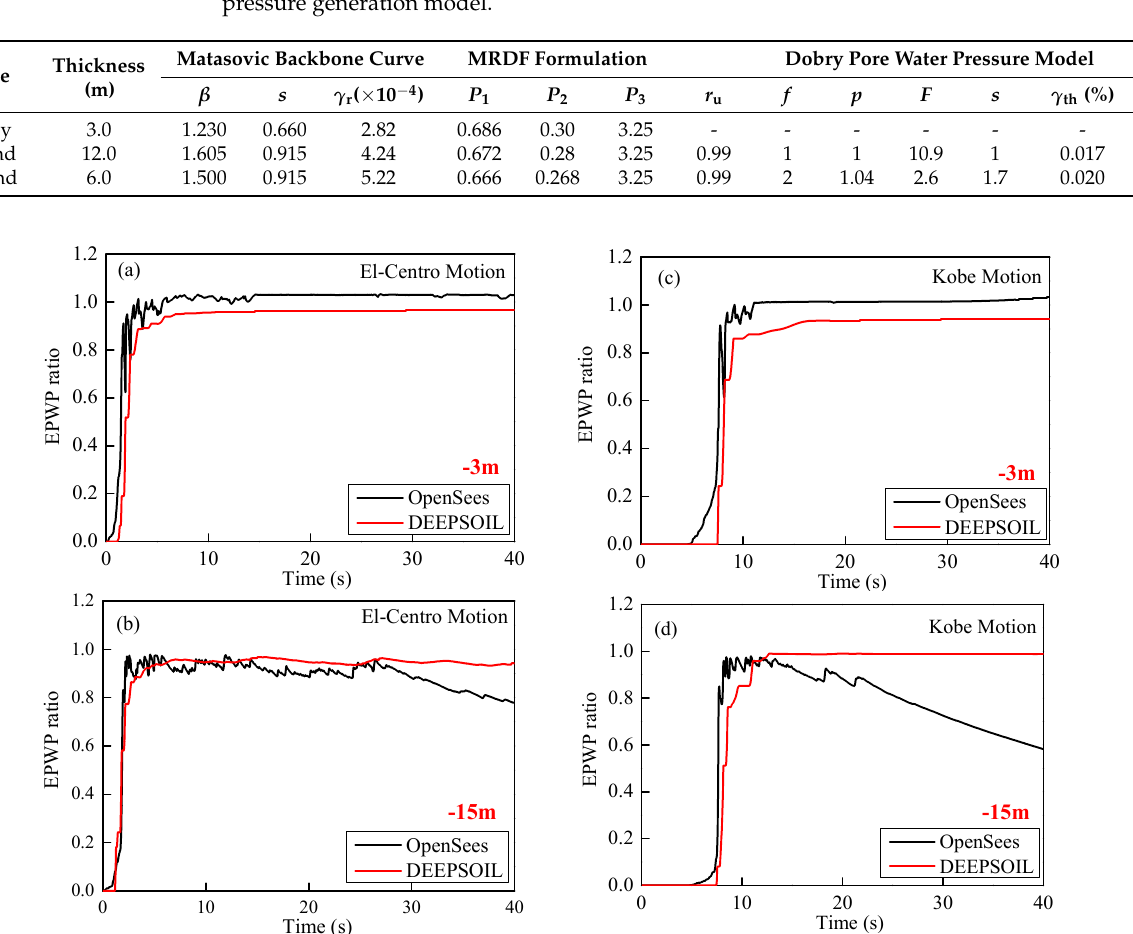
Figure 14. Development of excess pore pressure ratios: ( a ) −3 m; ( b ) −15 m under the El-Centro motion and ( c ) −3 m; ( d ) −15 m under the Kobe Motion.